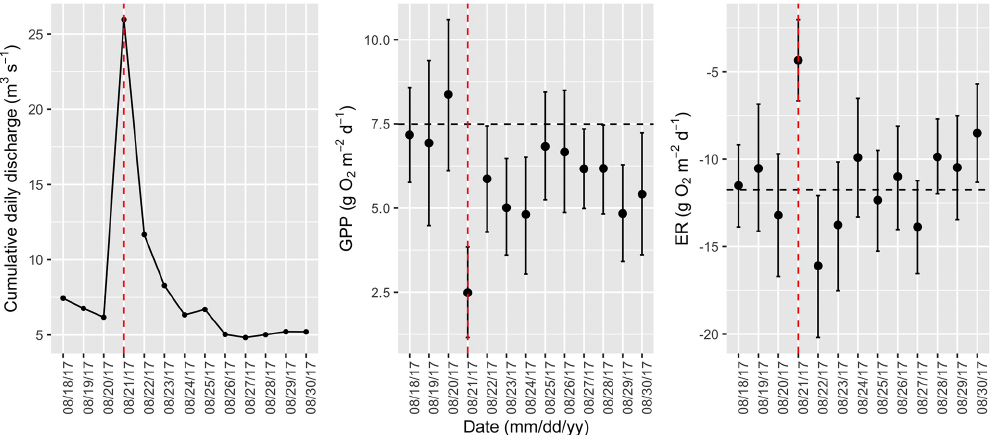
Figure A16. Cumulative daily discharge and metabolism (gross primary production and ecosystem respiration; GPP and ER) time series for the Stroubles Creek flow event on 21 August 2017 (noted with a dashed vertical red line in all three panels). The dashed horizontal black lines are mean values of GPP and ER prior to the high flow event. Error bars for posterior estimates of GPP and ER are 2.5% and 97.5% Bayesian credible intervals.